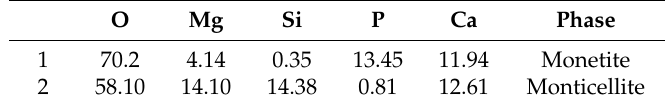
Table 9. EDS analysis (atom %) for directionally solidified rods grown at 100 mm/h after soaking in the SBF solution for 28 days.